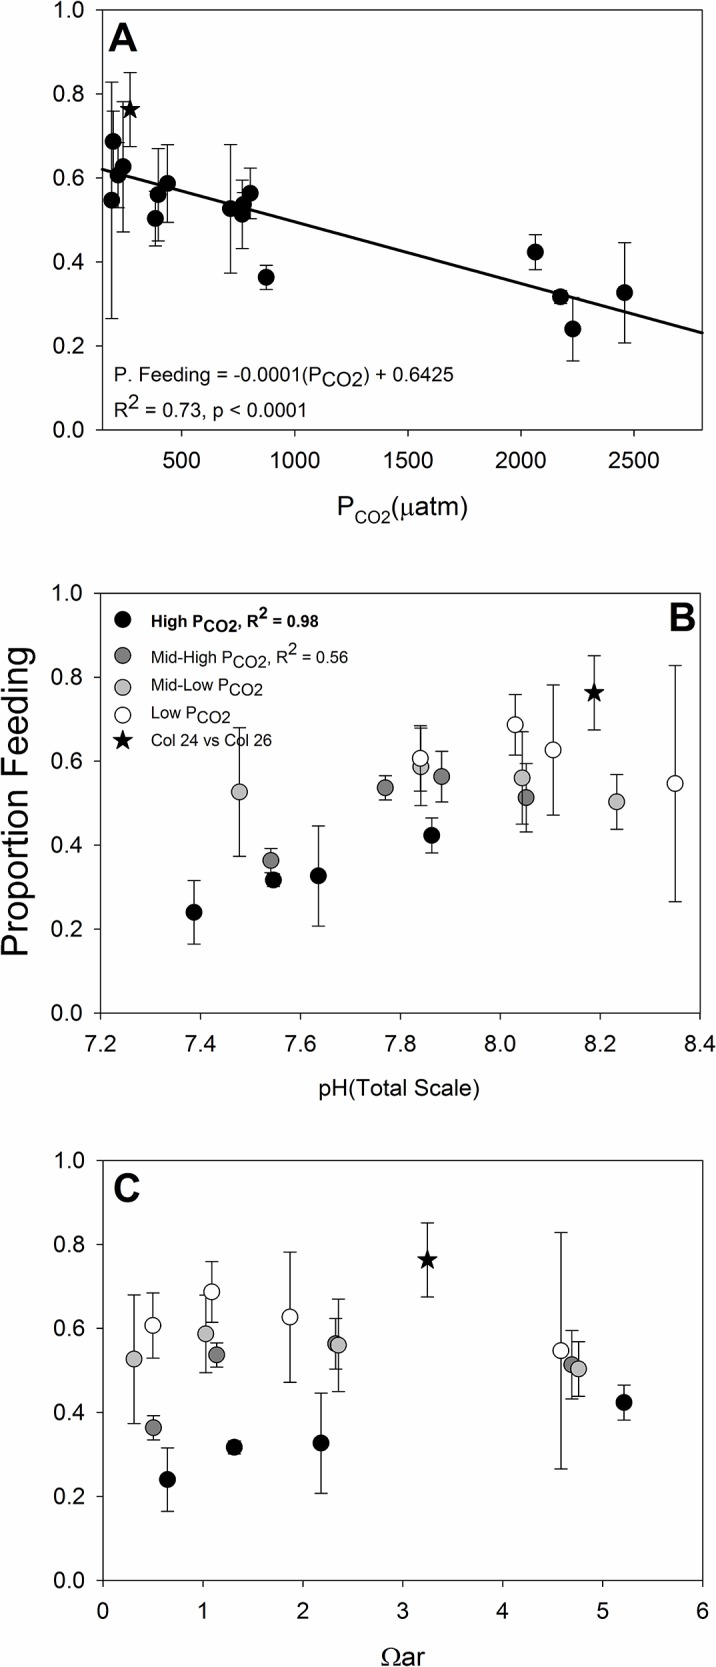
Initiation of Larval Feeding.The proportion of larvae feeding 44 hours post-fertilization and exposure in relation to (A) PCO2, (B) pH, and (C) Ωaragonite. Greyscale symbols denote PCO2 treatments in panels B and C. Error bars are standard deviations of the three replicate experimental containers per treatment. Bold value on panel B indicates the significant linear relationship between pH and initiation of feeding for the high PCO2 treatment. As noted in the text, the removal of this high PCO2 treatment results in extremely poor fit of the response to pH.